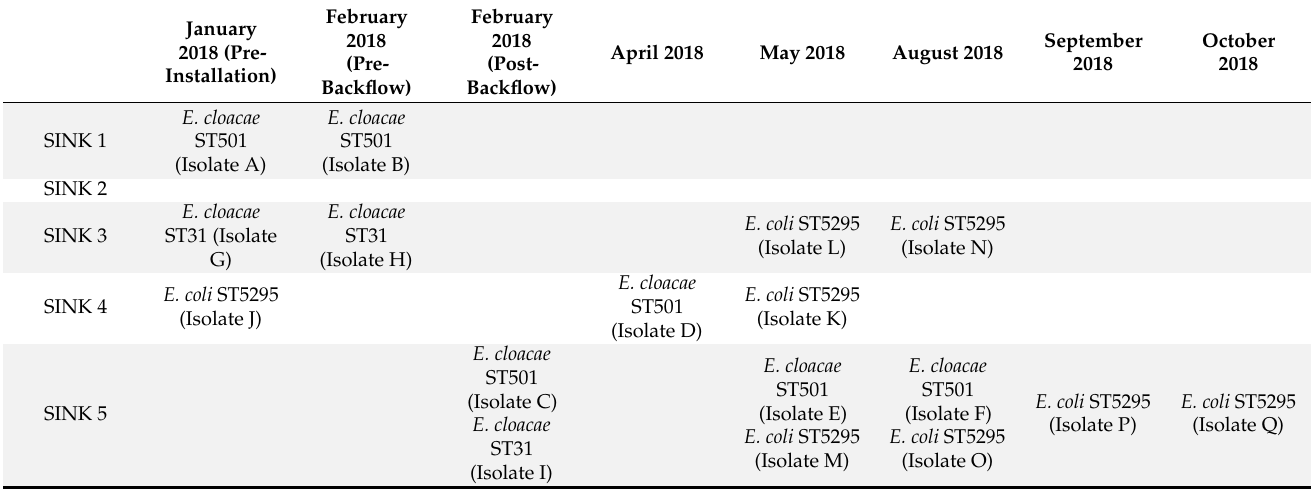
Table 1. Isolates characterised in this